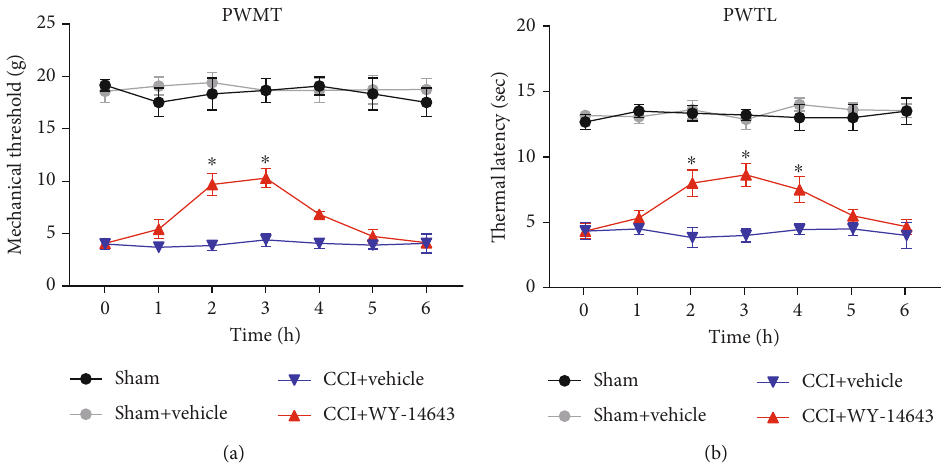
Figure 1: Acute WY-14643 treatment temporarily alleviated NP. (a) WY-14643 improved the paw withdrawal mechanical threshold (PWMT) of CCI rats. (b) WY-14643 improved the paw withdrawal thermal latency (PWTL) of CCI rats.